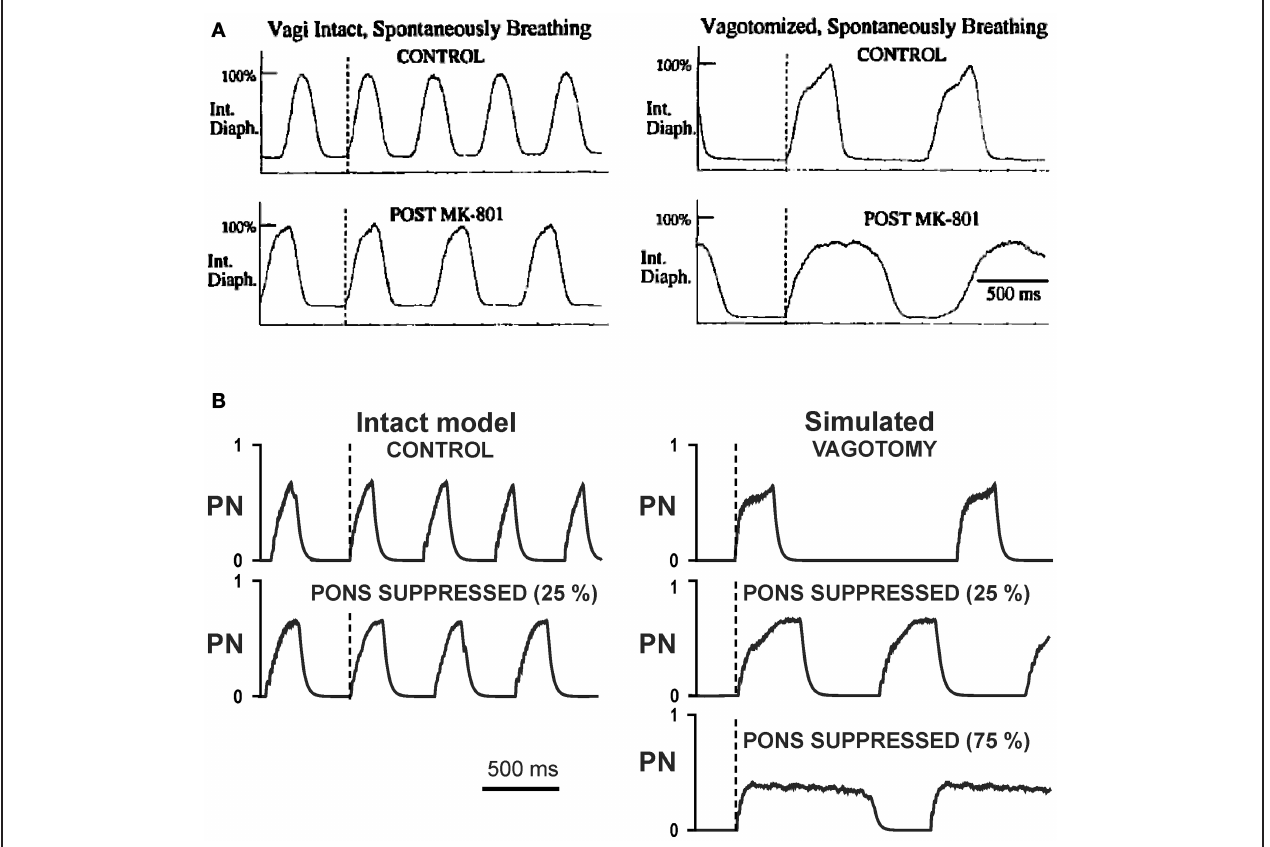
before (left diagrams) and after (right diagrams) vagotomy (from Connelly et al., 1992) (B) Changes in integrated phrenic nerve activity (PN) in our simulations before (top traces) and after (bottom traces) simulated pontine suppression, before (left diagrams) and after (right diagrams) simulated